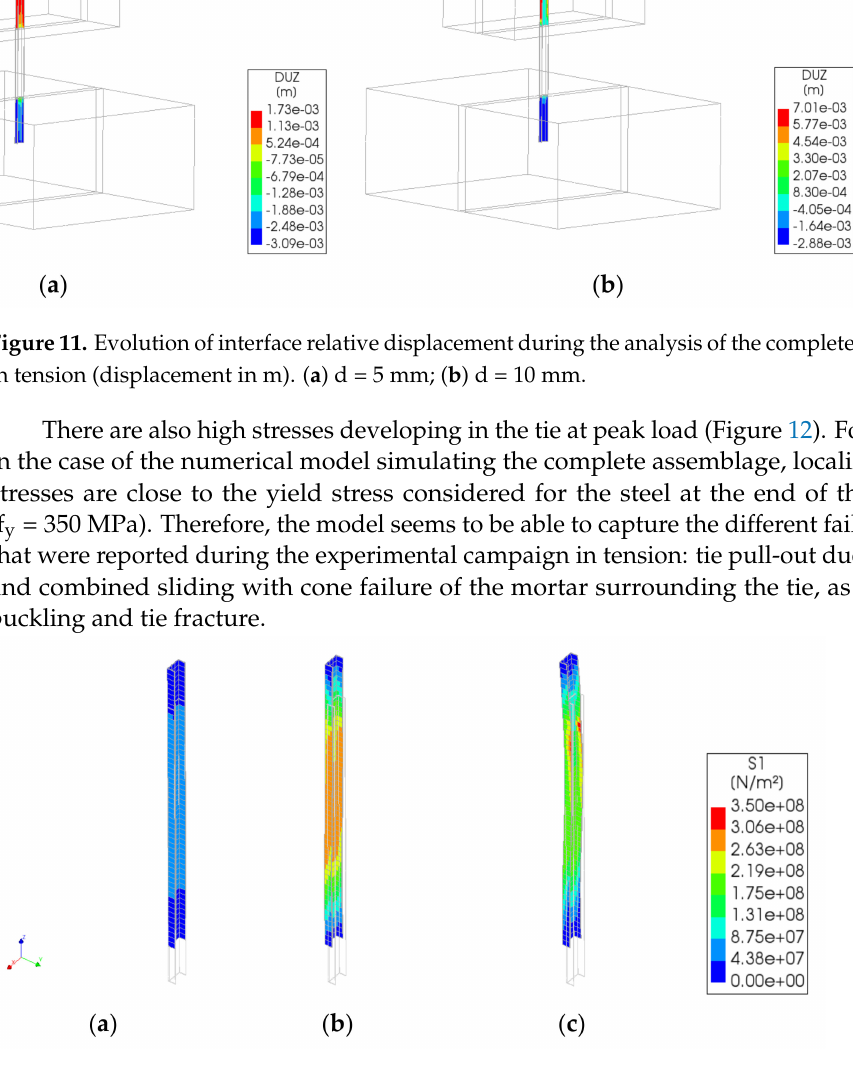
Figure 12. Evolution of principal tensile stresses at the tie (stresses in N/m 2 ). ( a ) d = 1 mm; ( b ) d = 5 mm; ( c ) d = 10